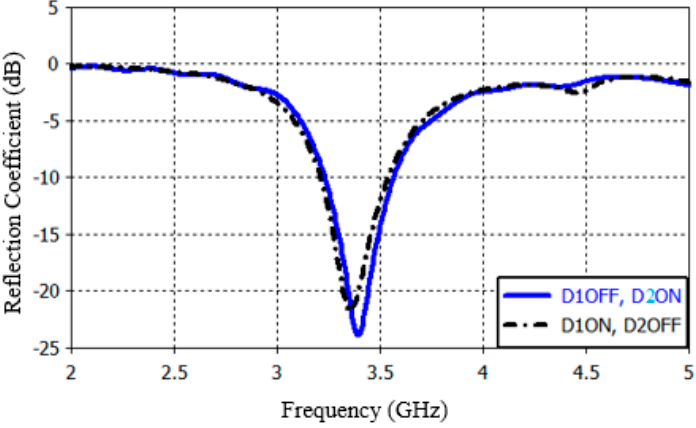
Figure 5. Simulated reflection coefficients for the proposed reconfigurable antenna.